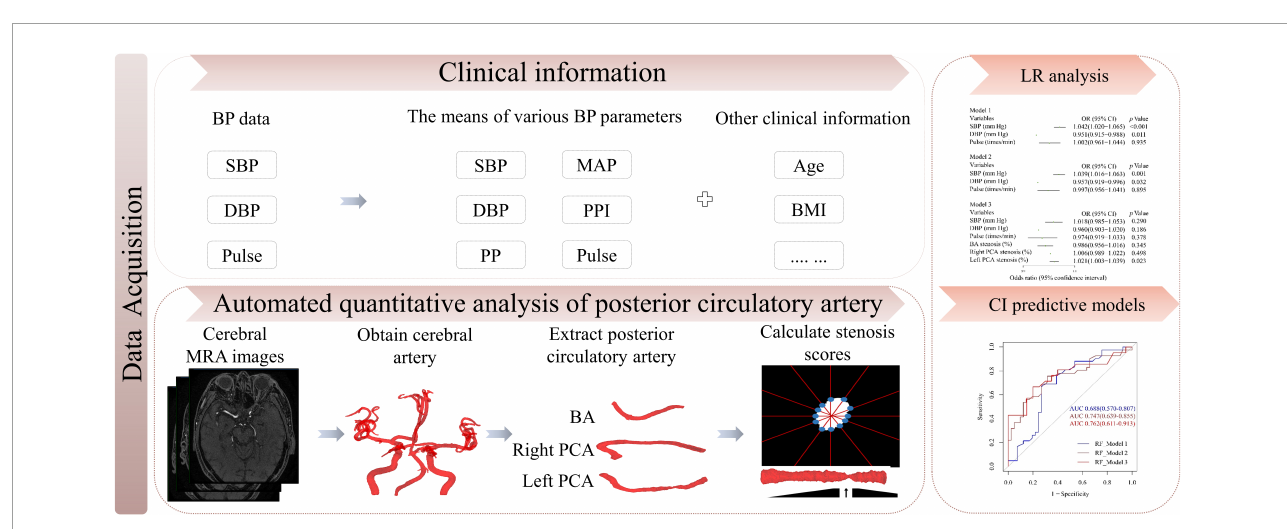
FIGURE2 Study flow chart. BP, blood pressure; SBP, systolic blood pressure; DBP, diastolic blood pressure; MAP, mean arterial pressure; PP, pulse pressure; PPI, pulse pressure index; BMI, body mass index; LR, logistic regression; CI, cognitive impairment; MRA, magnetic resonance angiography.